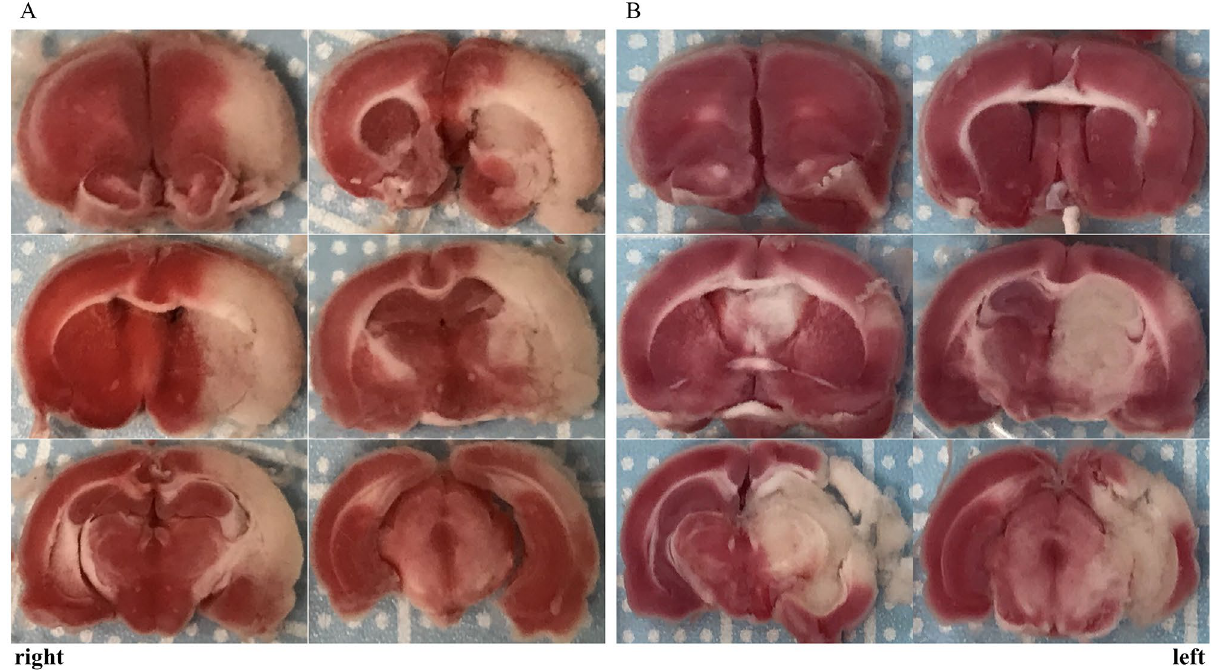
Figure 7. The brain is sliced and stained with 2% TTC solution 24 h after the left cerebral artery occlusion. ( A ) Brain infarction in the territory of only the MCA, but not in the AChA, VTA and HTA is clearly visible on TTC staining. ( B ) TTC staining showed that the left PCA territory changed post-infarction. Infarction of the hippocampus and substantia nigra were observed. AChA anterior choroidal artery, HTA hypothalamic artery, MCA middle cerebral artery, PCA posterior cerebral artery, TTC 2,3,5-triphenyltetrazolium chloride, VTA ventral thalamic